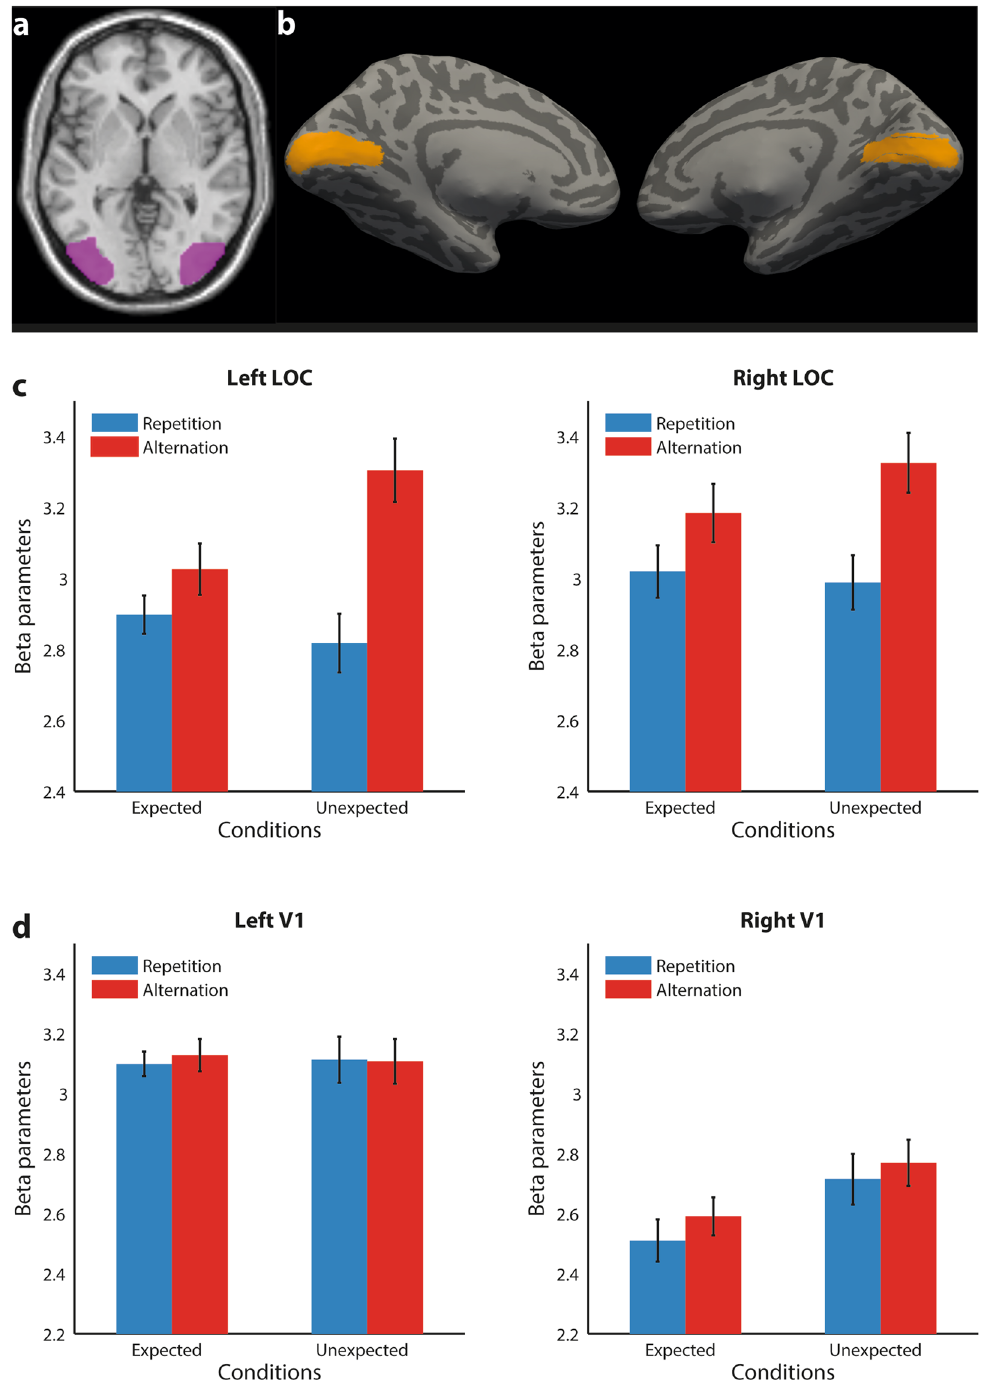
Figure 3. fMRI ROI results. (a) LOC ROI. Panel shows in violet the group response to the object > scrambles contrast during the localizer, and superimposed on a transversal slice of SPM’s MNI template at z = 0. For each participant individually, per hemisphere the 100 most object-selective voxels were chosen within this anatomical site. (b) Reconstructed V1 (left, right) shown in yellow on an inflated brain from one representative participant. (c-d) Mean parameter estimates for LOC and right V1 per condition. Error bars reflect within- subject SEM. Additional information on the ROI and beta parameters within these ROIs can be found in the supplementary Figures S1, S2, and